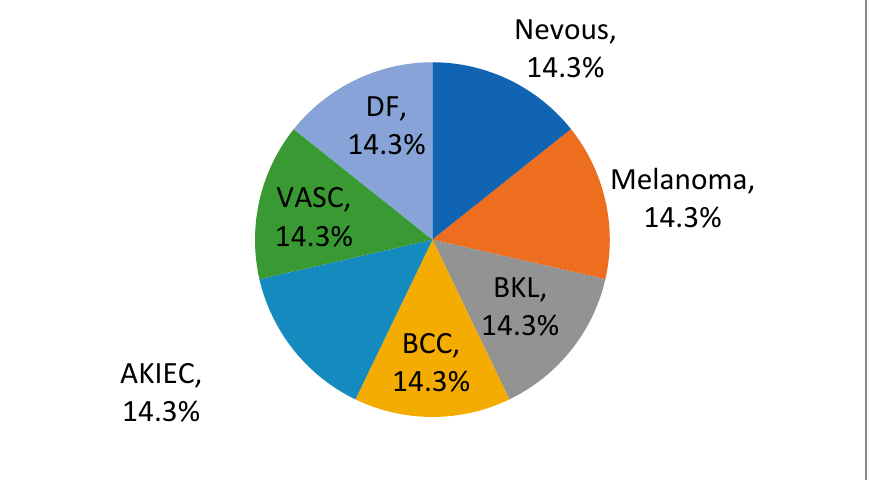
Figure 4. The augmentation dataset in its balanced form.